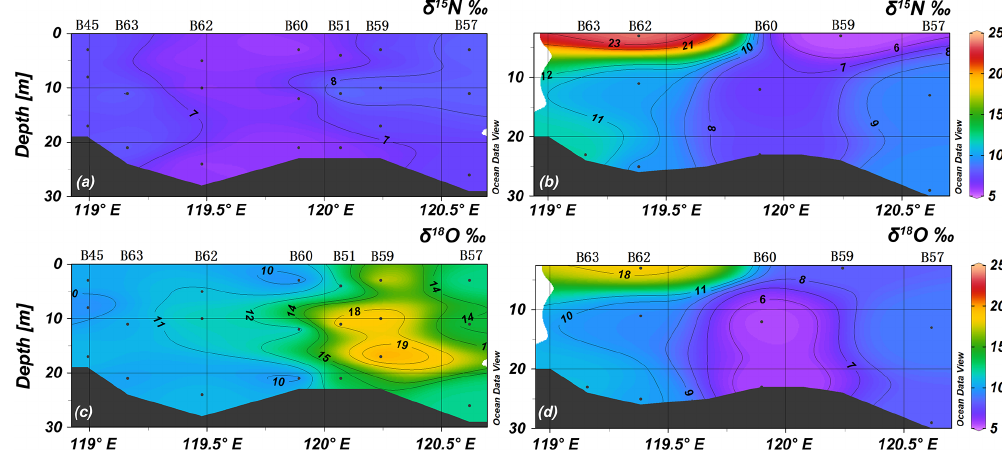
Figure 6. Nitrate isotopes (‰) of section 1 for spring (a, c) and summer (b, d) .